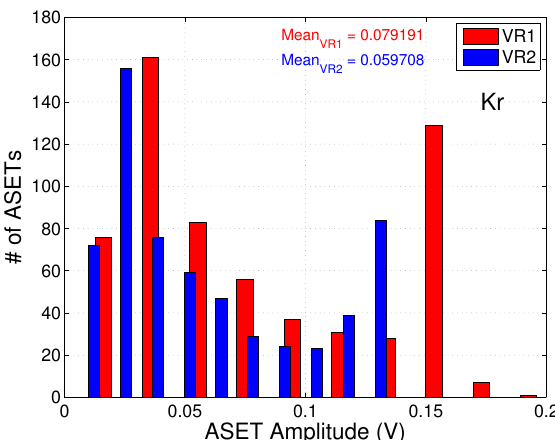
Figure 10. Measured number of ASETs versus ASETs peak amplitude for VR1 and VR2 circuits when exposed to Krypton.